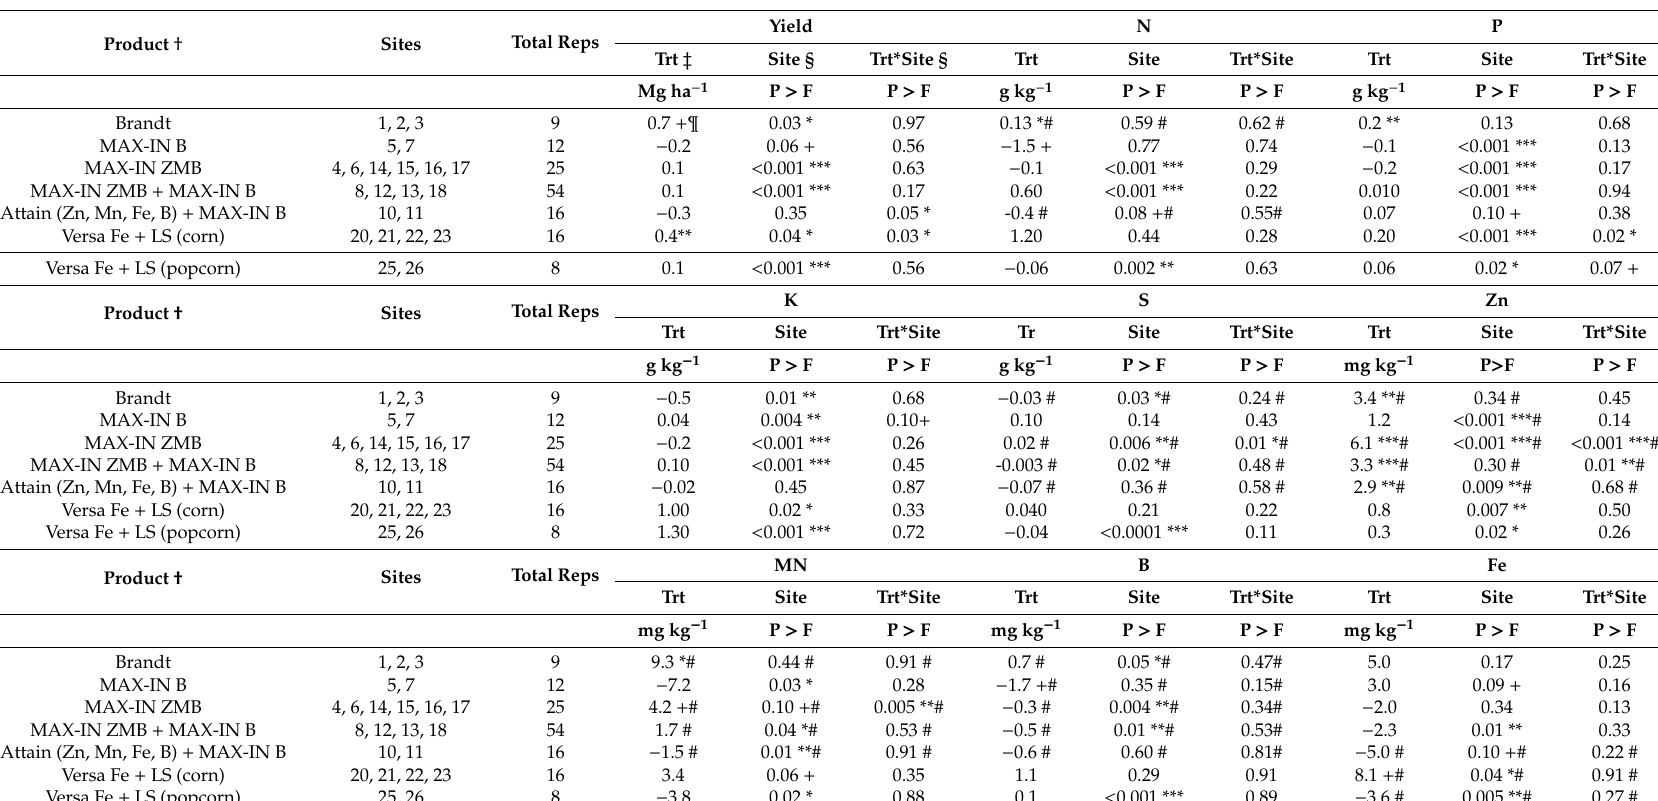
Table 5. The mean response across ≥ 2 sites for identical foliar micronutrient application compared to no application on grain yield and leaf tissue nutrient